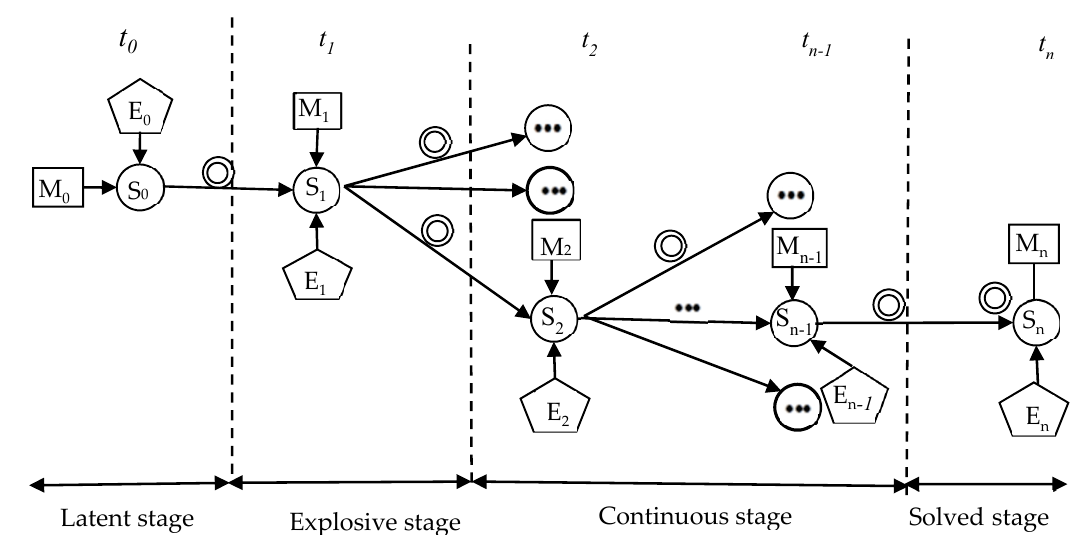
Figure 4. Scenario evolution law of waste NIMBY crisis. (Note: “E” means external situation, “S” means scenario state, “M” means emergency management, “ t “ represents different times, and “ ··· ” means due to the uncertainty of the situation, different new scenarios will appear).